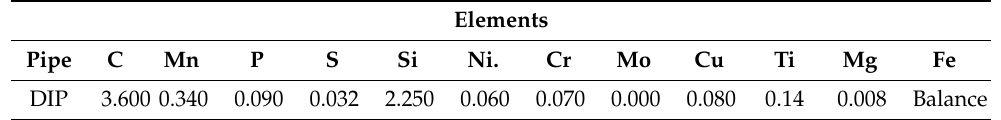
Table 2. The material composition of ductile iron pipe in wt%.